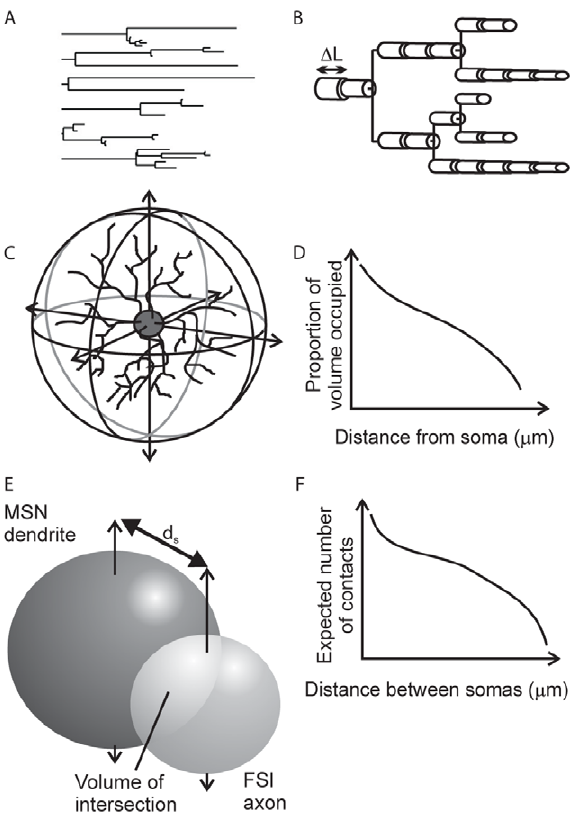
Figure 2. Anatomy model construction. Panels A–F show in order the steps involved in moving from a dendrite model to a probability function of contacts between two neuron types. A We create complete dendrograms using a stochastic algorithm, bounded by known properties of the dendrites. This example shows all six dendritic trees of the complete dendrogram for one MSN. B Each segment of each branch is modelled as a cylinder. The diameter of successive cylinders tapers with distance from the soma. Summing over all branches gives the total volume of dendrite (or axon) at each distance from the soma. C We then compute the proportion of spherical volume occupied by dendrite (or axon) at each distance from the soma. D Expected values for occupied volume are computed over many repetitions of the growth algorithm. The result is a continuous function of volume occupancy for each dendrite and axon type. E We find the intersecting volume between the dendrite and axon spherical fields for each distance d s between somas. The volumes are discretised into 1 m m 3 voxels. F For each voxel, given its distance from the respective somas, we compute the probability of intersection between neurites (dendrite- axon or dendrite-dendrite) from the volume occupancy functions (in panel D). We then sum over all probabilities to get the expected number of intersections between neuron pairs as a function of distance between their somas. We use the resulting functions to construct our networks. and the algorithm moves to the segment on the next unfinished branch. This algorithm is repeated from a single starting segment to obtain each of the dendritic trees necessary to form a complete dendrogram: we built 6 trees for a complete MSN dendrogram [40,53,54], and 5 trees for a FSI [37]. The dendrogram records the diameter, distance from soma, parent segment, and end type (branch, termination, or continuation) of each dendritic segment.